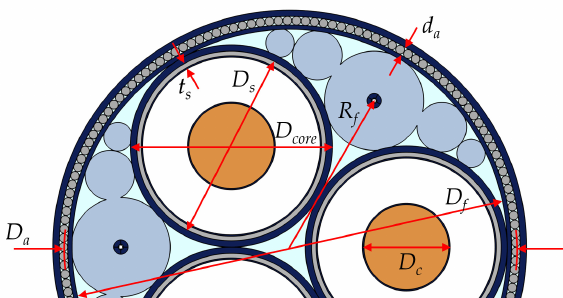
Figure 6. Main dimensions in a TCAC.